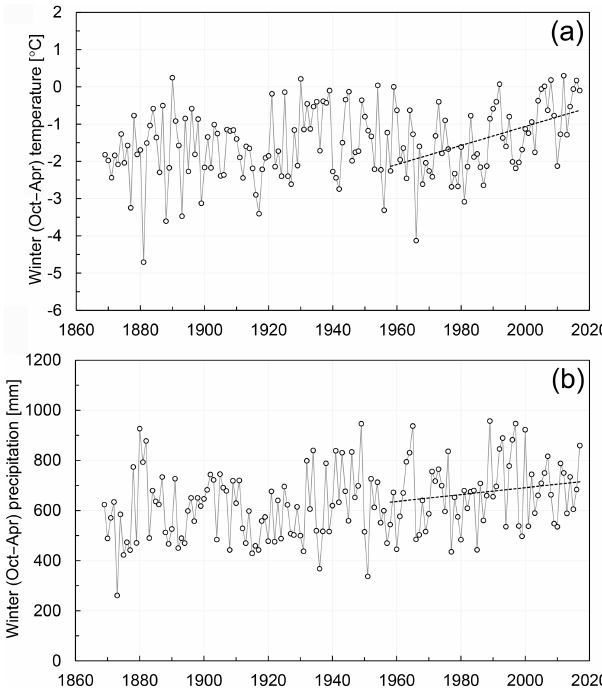
Figure 3. Mean winter temperature (a) and total winter precipita- tion (b) measured at the Tromsø meteorological station in the pe- riod 1867–2017. The stippled line indicates the trend in the period